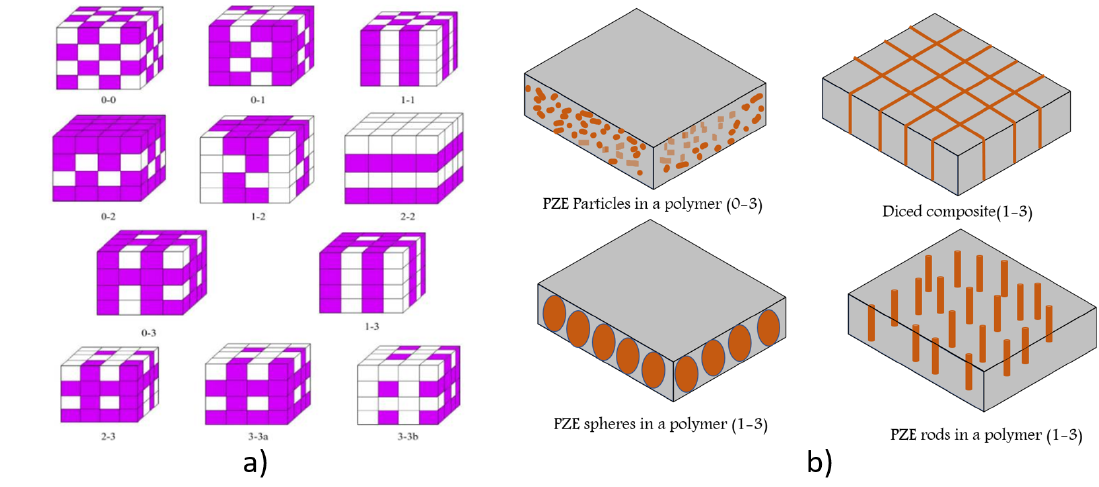
Figure 5. ( a ) Connectivity patterns for piezoelectric ceramic and polymer composites. Reprinted with permission from [40] c (cid:13) 2012 Elsevier. ( b ) Connectivity of piezo